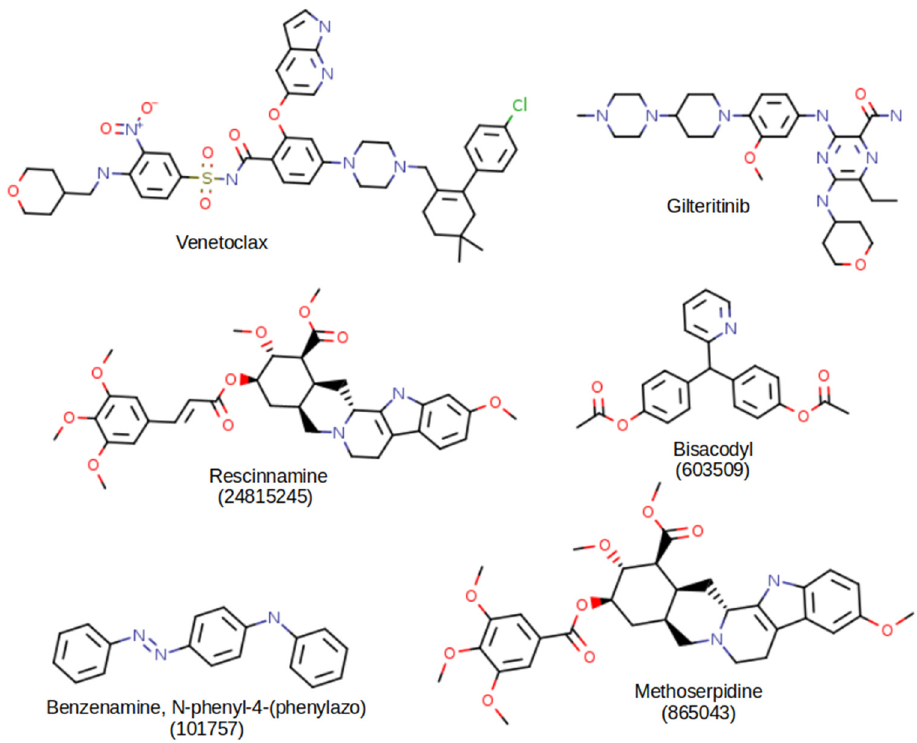
Figure 5. The known antileukemia drugs venetoclax and gliteritinib that target BCL-2 and FLAT3, respectively, and the four most promising antileukemia candidates predicted from the docking study.